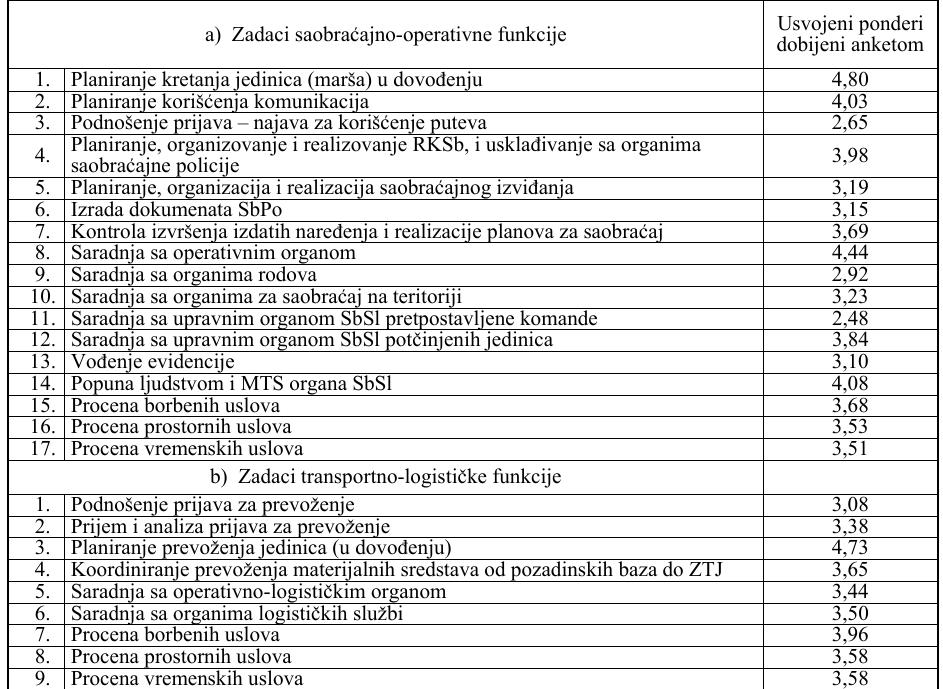
Ponderi zadataka funkcija SbPo u pripremi operacije a) Zadaci saobra}ajno-operativne